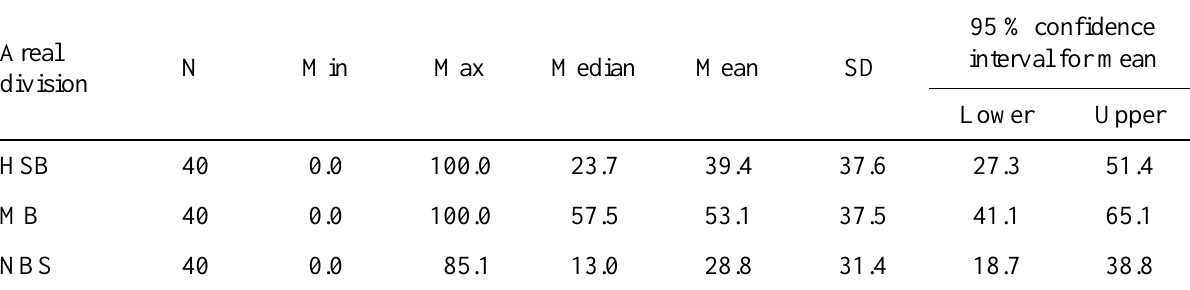
Table 8. The proportion of the total mineral ground area within an aapa mire's catchment that is upslope of a drained margin